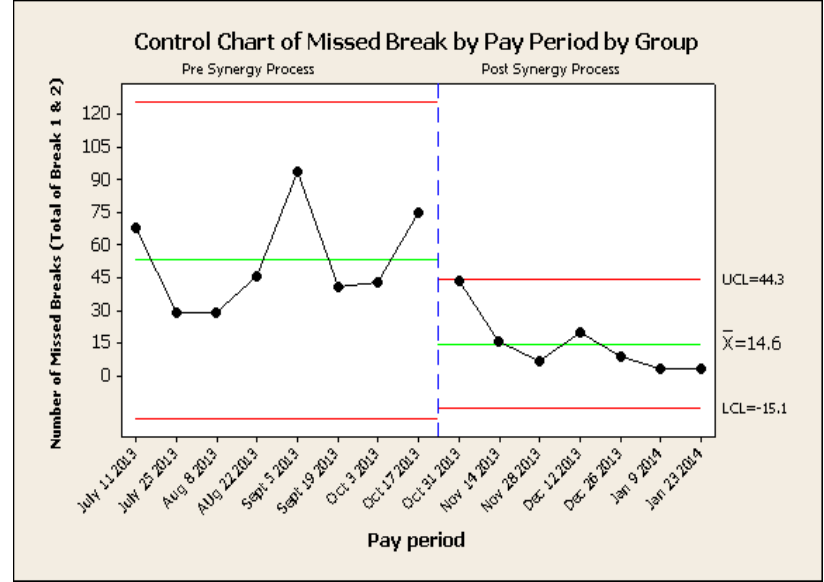
Figure 4. Nurses’ Missed Breaks on the HHSC Hematology Unit.